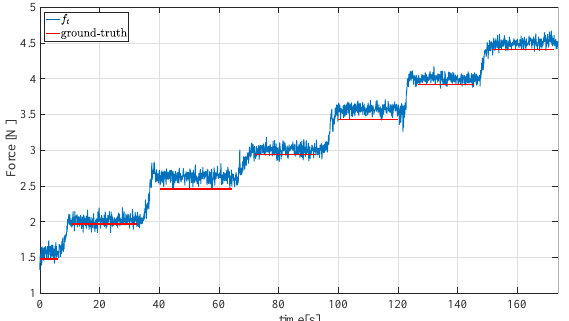
Figure 16. Second experiment: Assessment of the reconstruction of the grasped object weight—first grasp.